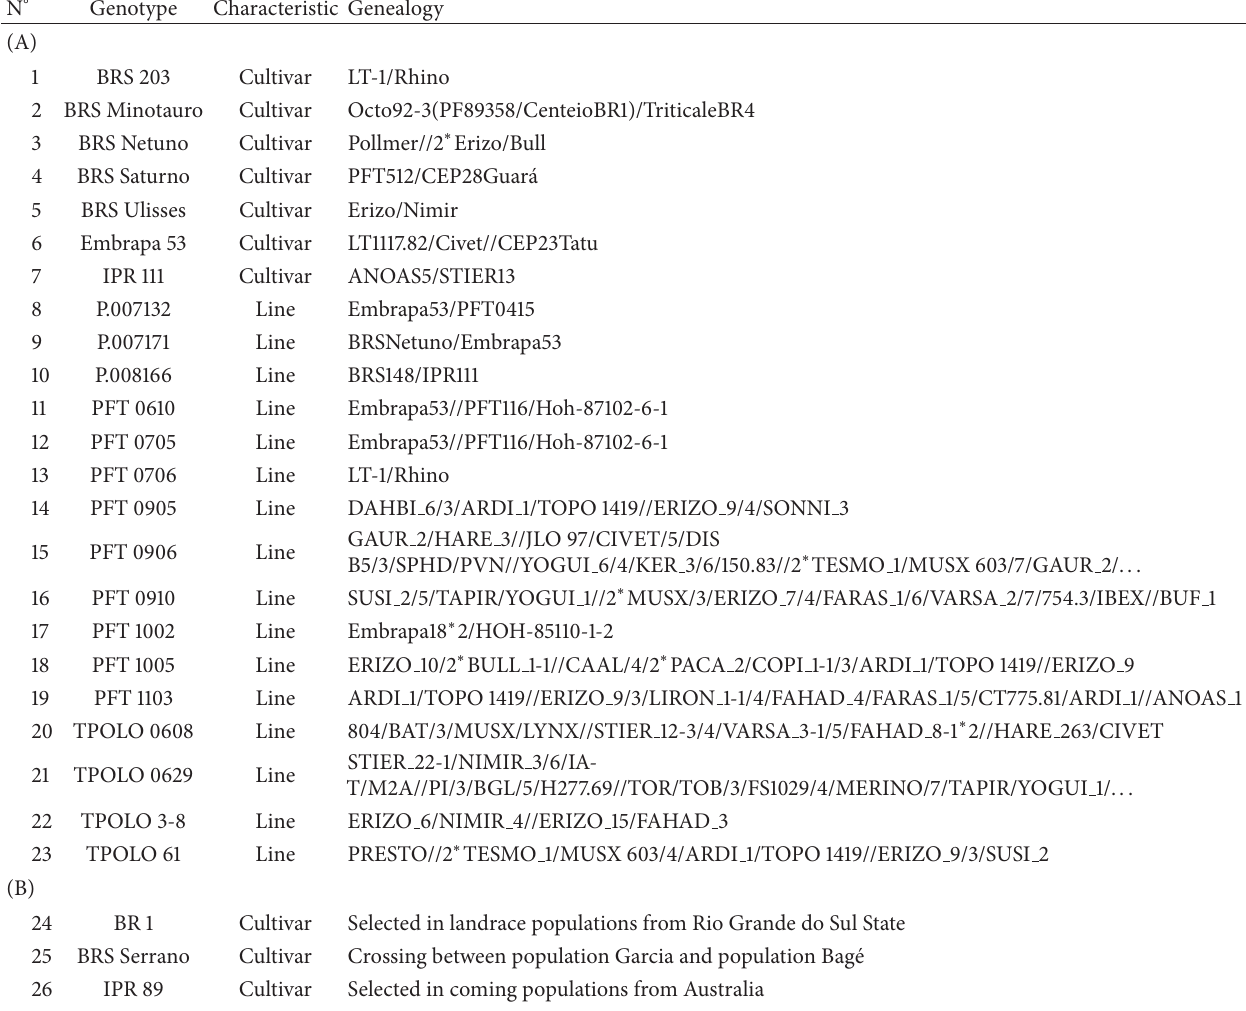
Table 1: (A) Triticale and (B) rye genotypes used in the